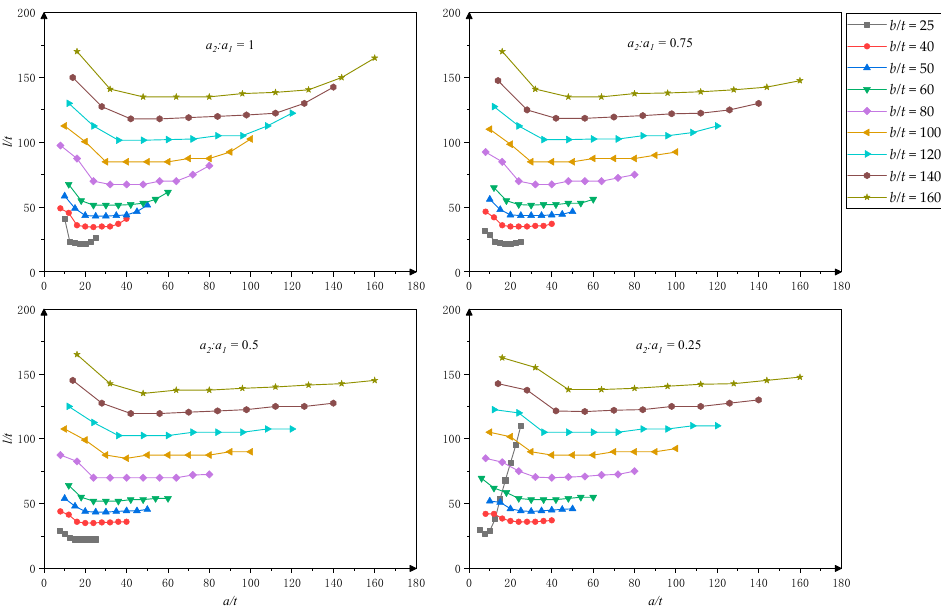
Figure 8. Values of l/t of the complex edge stiffeners for different a 2 / a 1 ratios.